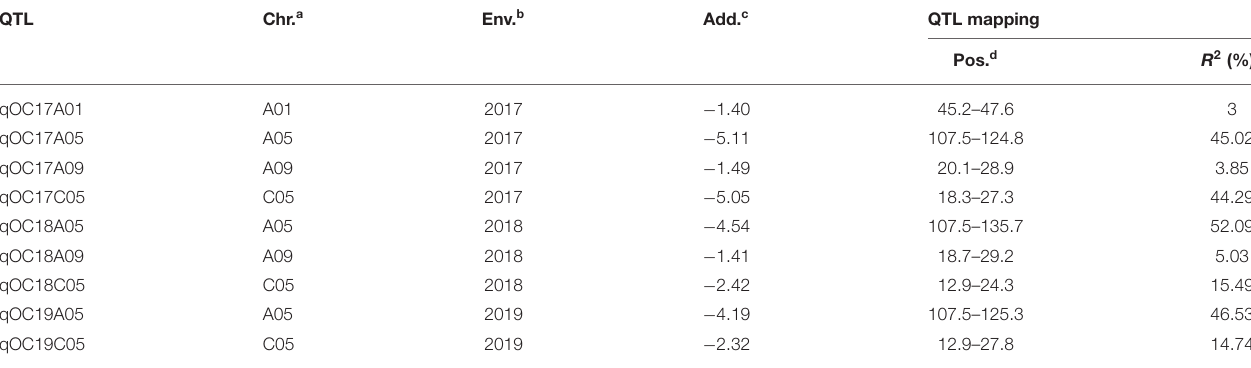
TABLE 1 | QTL for seed oleic acid content in a segregating Brassica napus F 2 : 3 population. QTL Chr. a Env. b Add. c